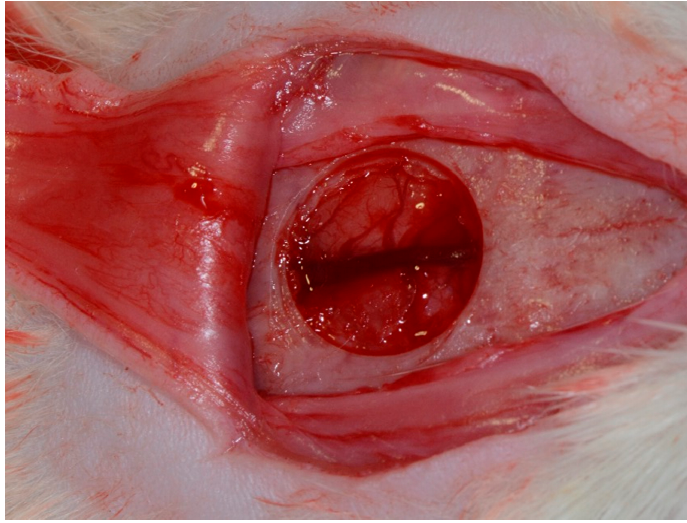
Figure 2. Surgical approach to calvaria and defect creating.